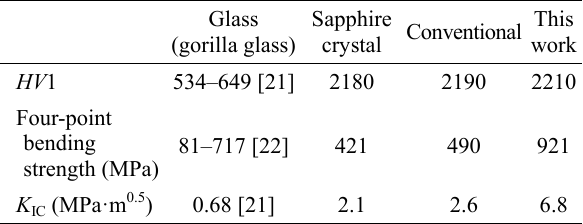
Comparative mechanical properties of common glass, c -axis sapphire, and conventional and advanced alumina